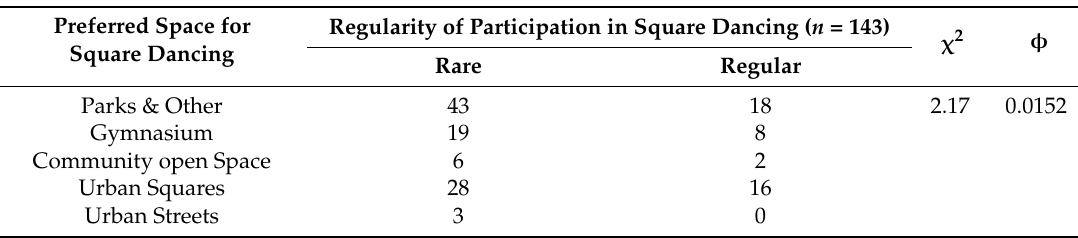
Table 17. Chi Squared Test comparing preferred location of Square Dance with regularity of